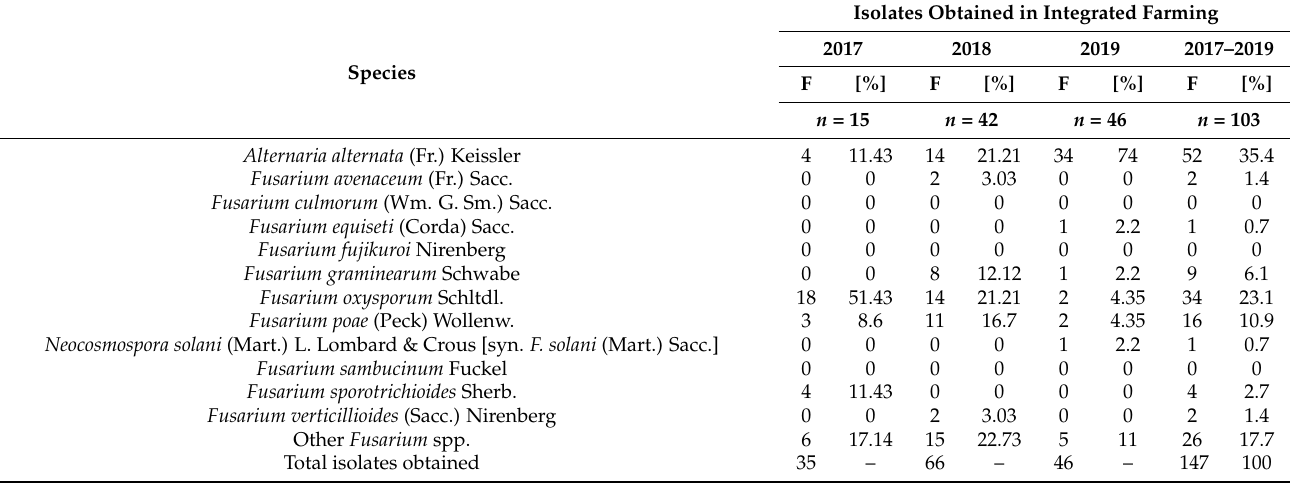
Table 8. Fungi isolated from infected maize plants from 2017 to 2019 in the integrated cropping system.